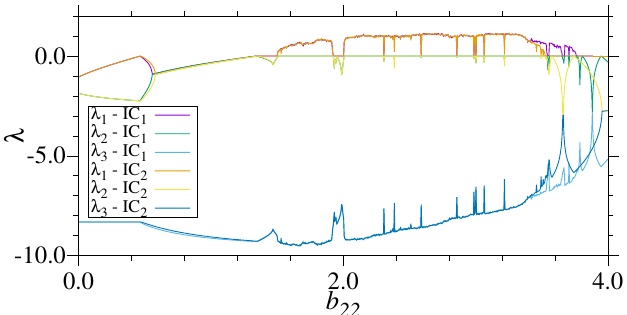
Figure 8. Lyapunov exponents λ i for i = 1,2,3 at each value of bifurcation parameter b 22 .